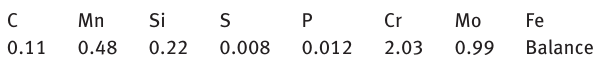
Table 1: Chemical composition (weight percent) of initial